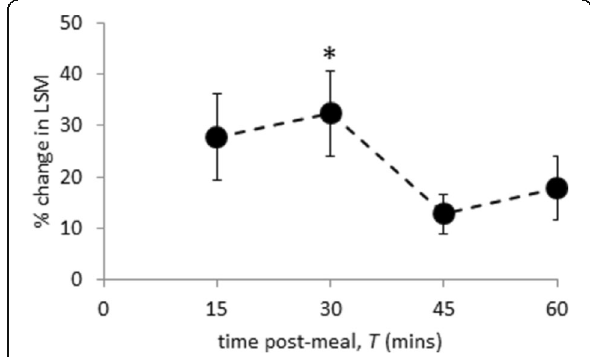
Fig. 3 Percentage change in liver stiffness measurement (LSM) from baseline, following meal ingestion (mean ± standard error of the mean) in healthy participants. Comparison of each time point with baseline, * p < 0.05. T